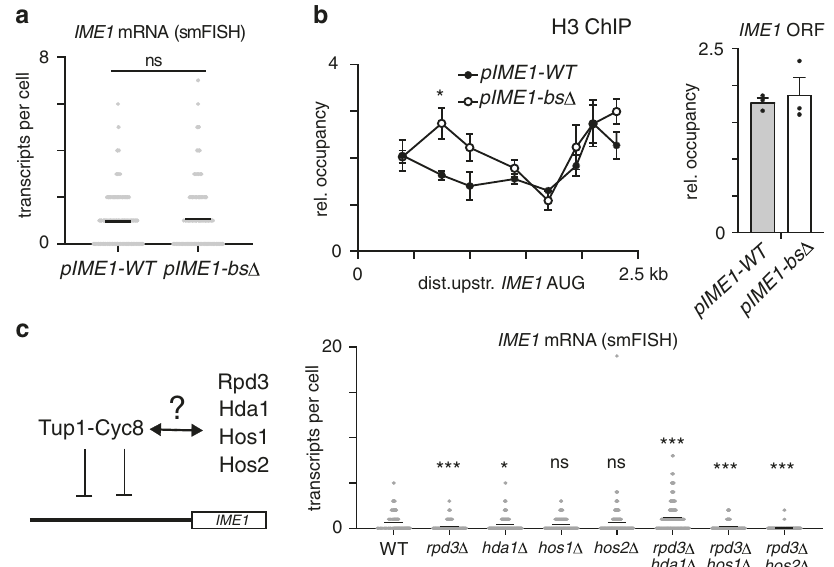
Fig. 4 Tup1 – Cyc8 does not directly regulate chromatin state. a IME1 expression in pIME1-WT (FW5370) and pIME1-bs Δ cells (FW5372) grown to exponential growth in rich nutrient conditions (YPD) detected by smFISH. The mean number of transcripts per cell for each time point (black line) is displayed. At least 200 cells were used for the analysis. Unpaired parametric two-tailed Welch ’ s t test with 95% con fi dence was used. Non-signi fi cant (ns) p value is indicated. b Histone H3 occupancy across the IME1 promoter and the IME1 ORF in pIME1-WT and pIME1-bs Δ cells grown as described in ( a ). The signals were normalised over the HMR locus. The mean and SEM of n = 3 are shown. * corresponds to a p value of ≤ 0.05 compared to pIME1-WT control on a two-way ANOVA followed by a Fisher ’ s LSD test with 95% con fi dence. c Schematic of Tup1 – Cyc8 interacting with histone deacetylases (HDACs) (left). IME1 expression in diploid cells harbouring rpd3 Δ , hda1 Δ , hos1 Δ and hos2 Δ single deletions (FW8102, FW8426, FW8430 and FW8103) or rpd3 Δ hda1 Δ , rpd3 Δ hos1 Δ and rpd3 Δ hos2 Δ double deletions (FW8457, FW8428 and FW8171) in single cells as determined by smFISH (right). The mean number of transcripts per cell (black line) is displayed. At least 100 cells were used for the analysis. Unpaired parametric two-tailed Welch ’ s t test with 95% con fi dence was used to compare IME1 expression in mutant cells with wild-type control cells. p values (ns = non-signi fi cant, * = ≤ 0.05, *** = ≤ 0.001) are